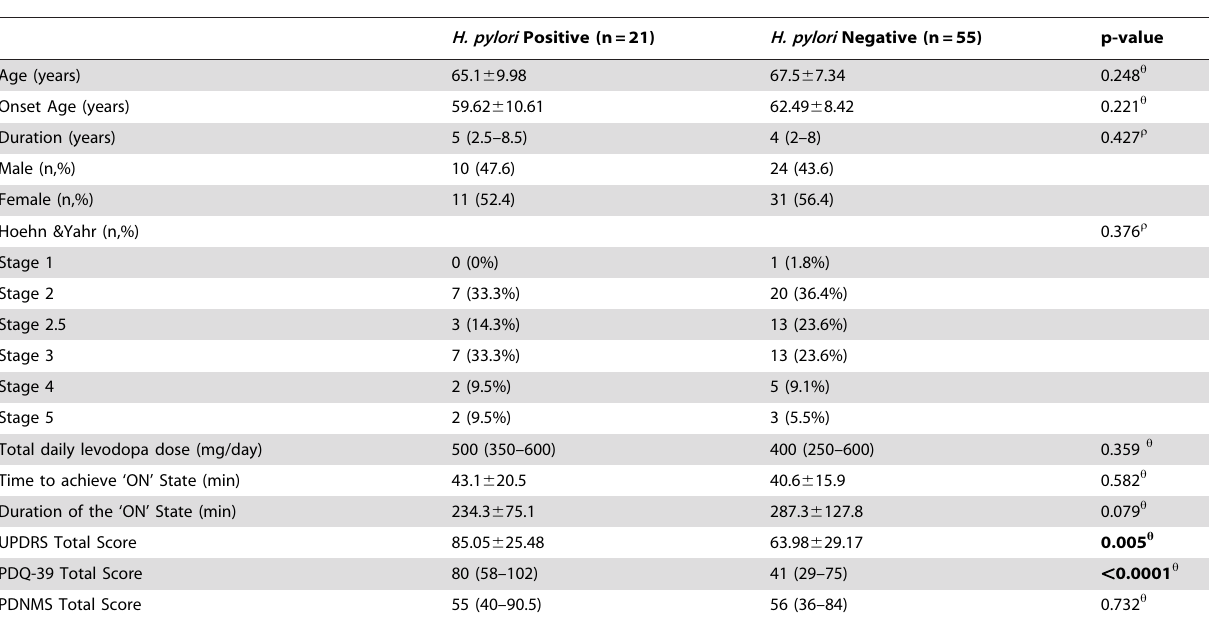
Table 1. Demographic and clinical status of H. pylori -positive and H. pylori -negative